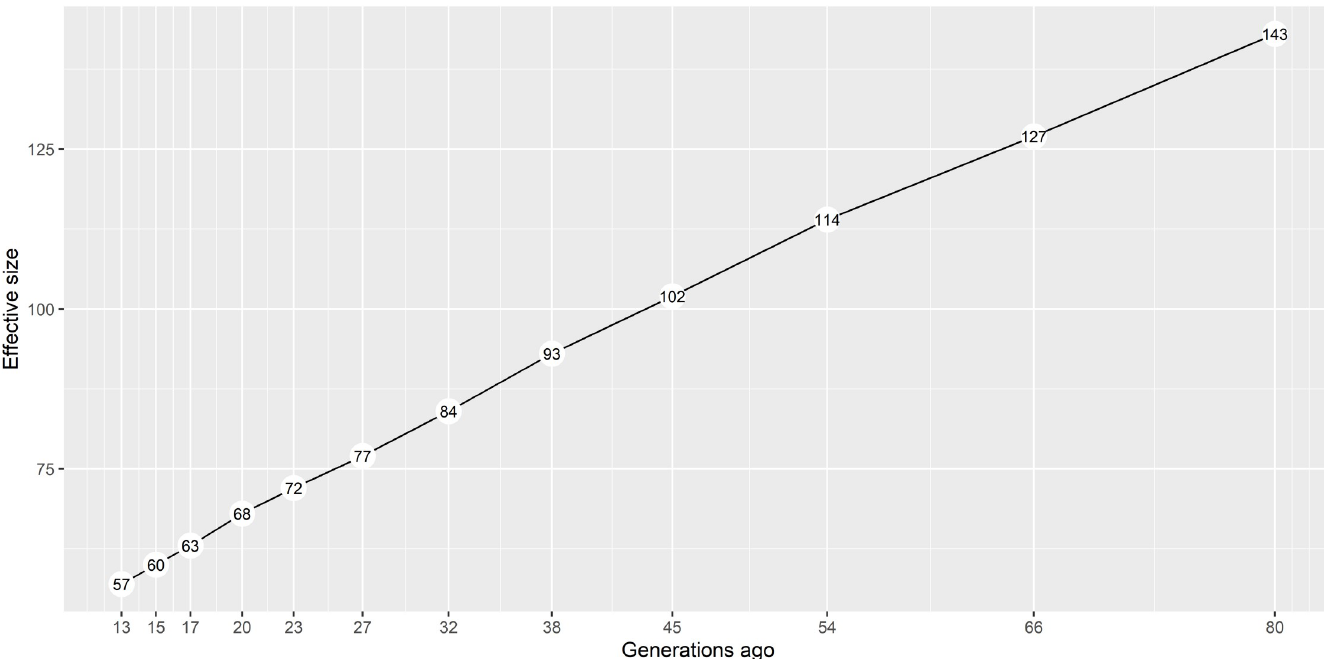
Fig 2. Historical effective size trend in the British Lop population. Calculated based on a dataset of 176 genotypes and 36,048 SNPs, using the SNeP software and the mapping function of Sved & Feldman.